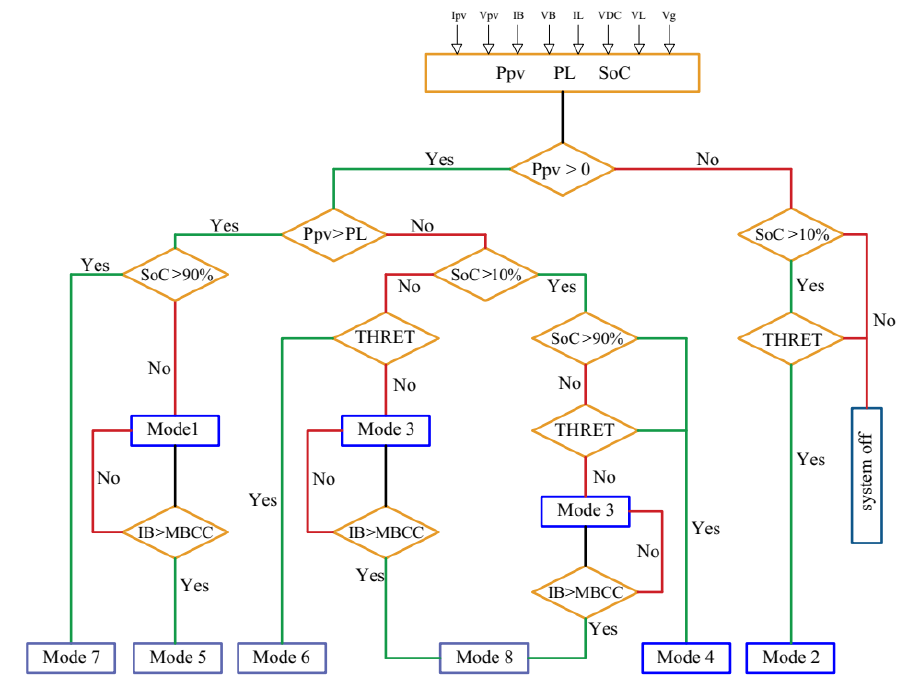
Figure 3. The proposed DSM algorithm.